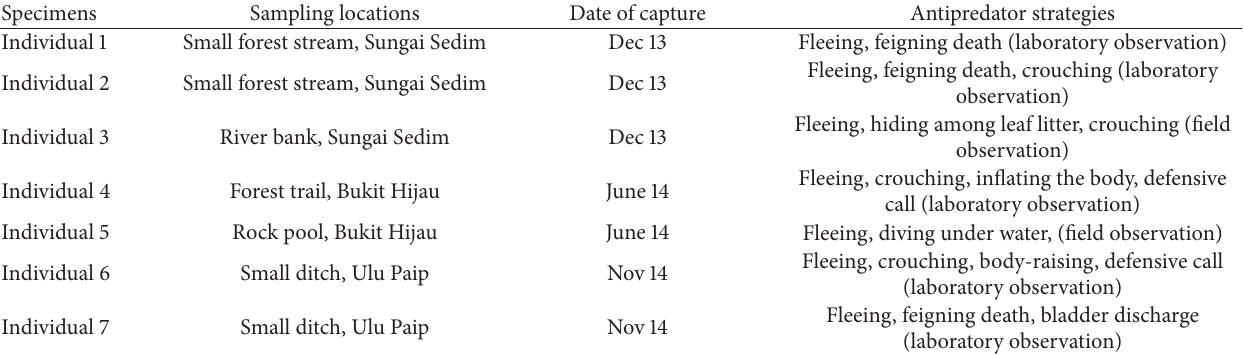
Table 1: Antipredator strategies displayed by Limnonectes blythii from Kedah, Peninsular